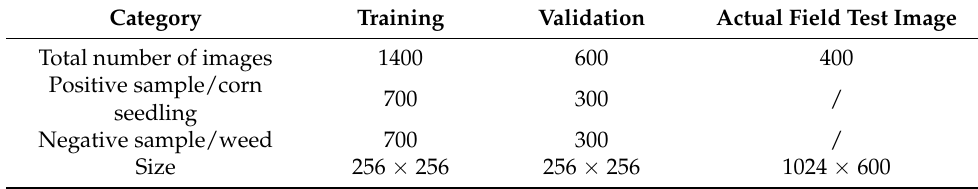
Figure 5. Negative sample dataset. Table 1. Number of data sets and image size.